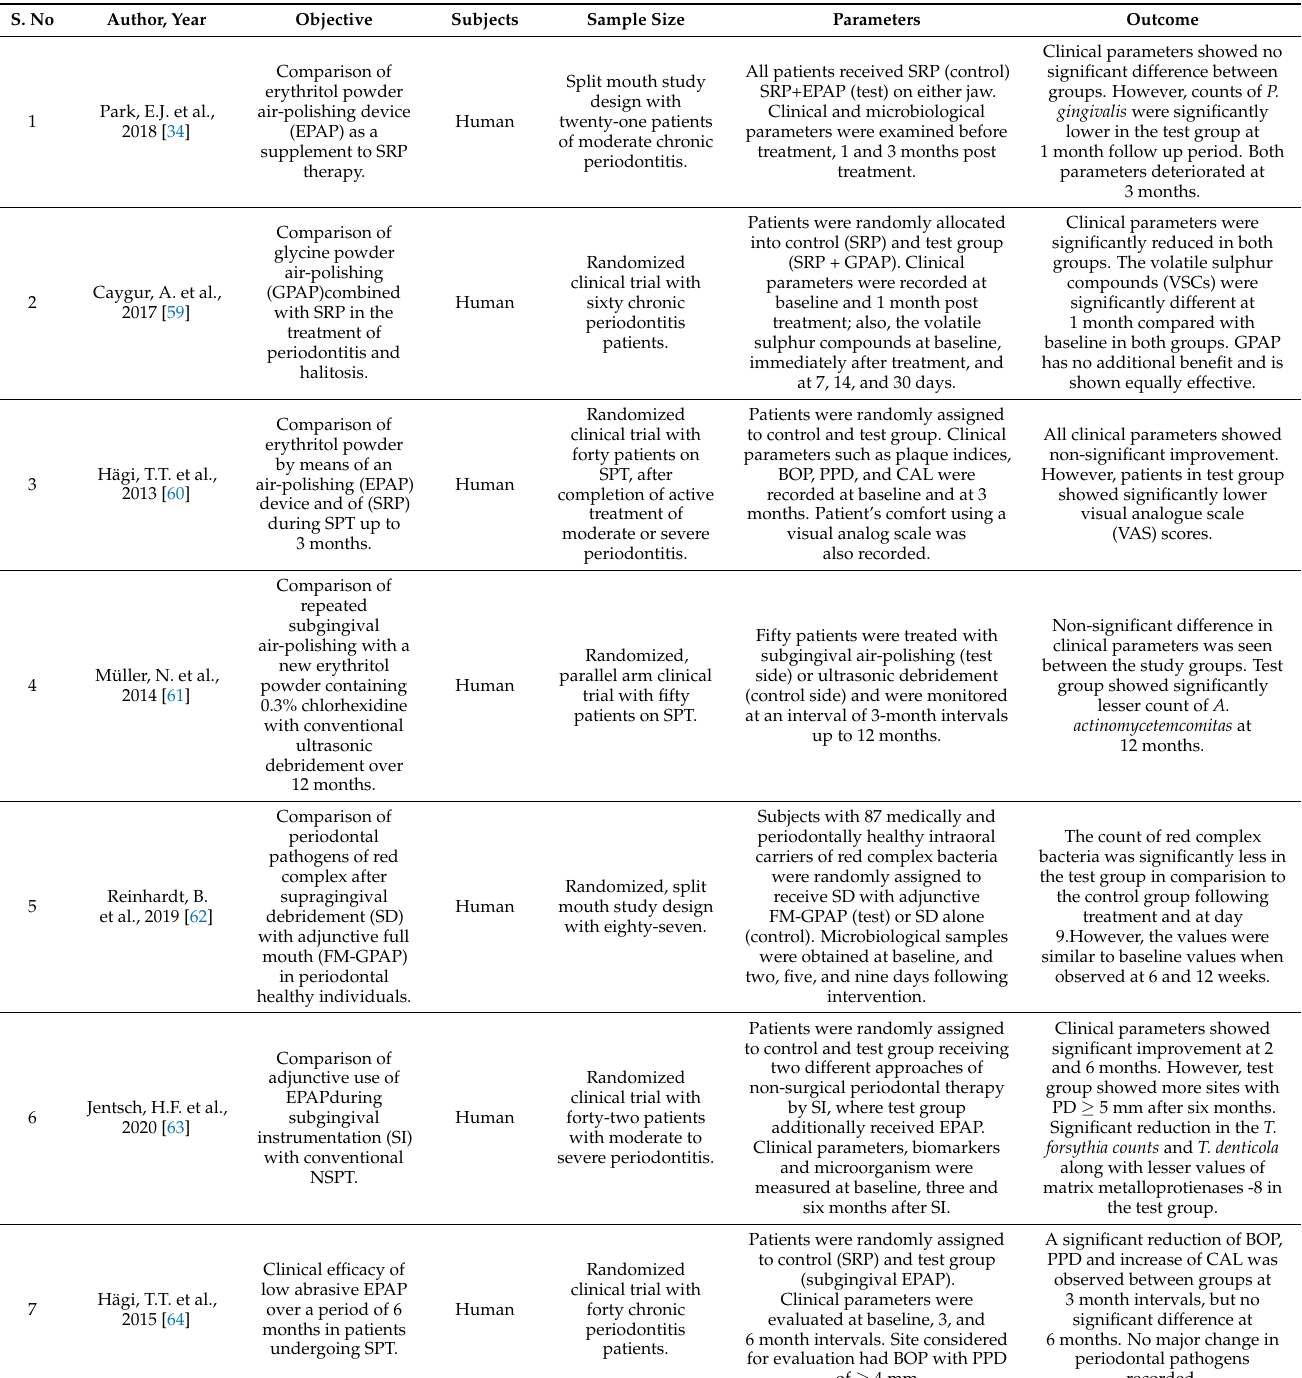
Table 2. Studies with glycine/erythritol as an air-polishing agent in the treatment of periodontal diseases/peri-implant